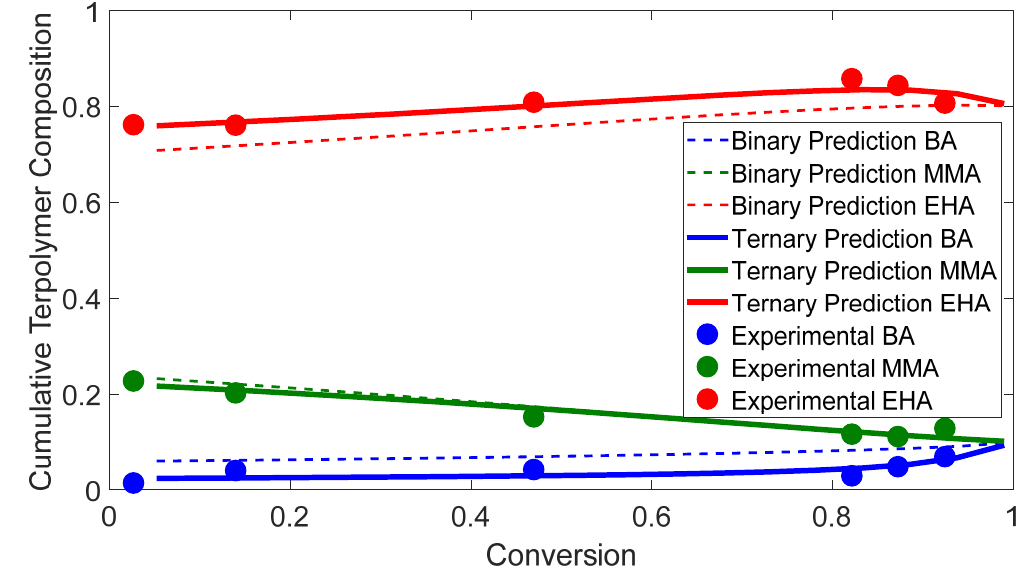
Figure 8. Prediction of cumulative terpolymer composition for BA / MMA / EHA (f BA,0 / f MMA,0 / f EHA,0 = 0.1 / 0.1 / 0.8) (experimental data and binary predictions from [12]).